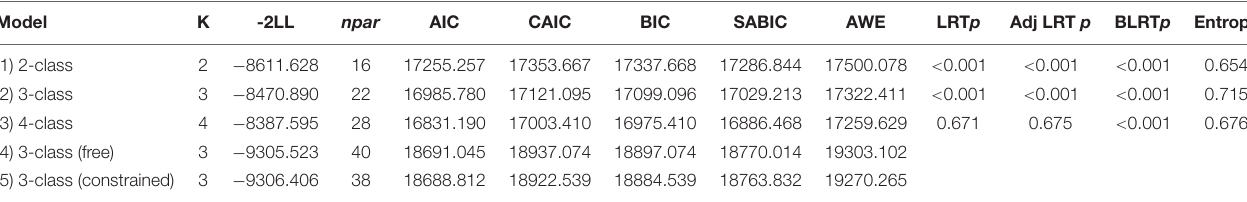
TABLE 2 | Model fit statistics for the Latent Profile Analysis of the personality profile.